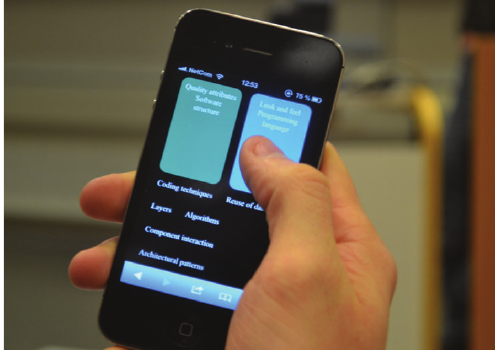
Figure 7: Playing the Categories game in lecture